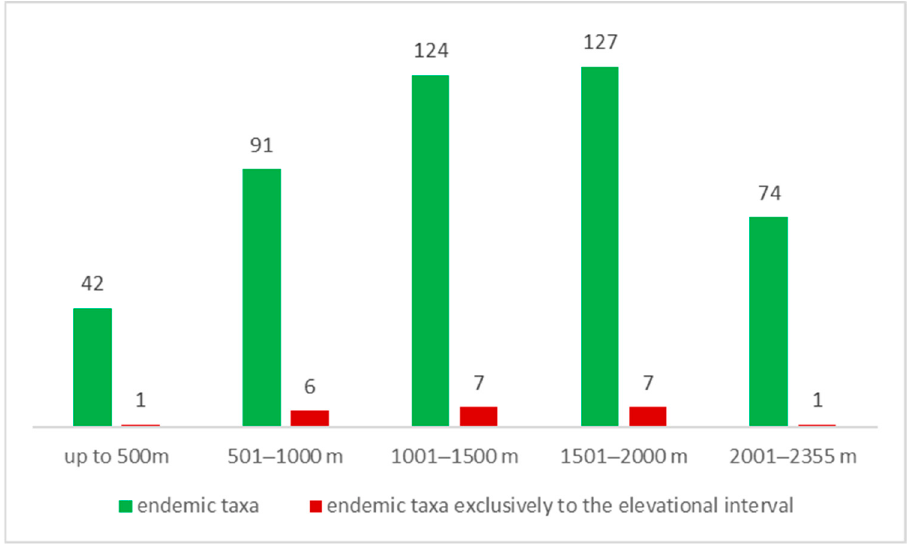
Figure 4. Altitudinal distribution of CVNP’s Greek endemic taxa into five 500 m elevational intervals.